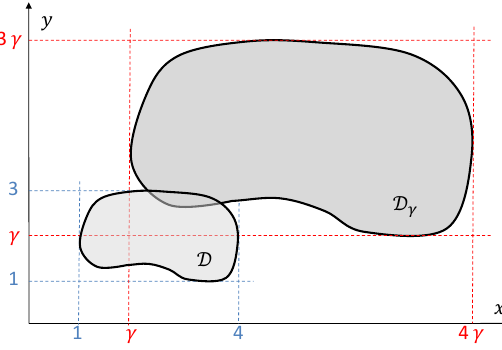
Figure 4. Constructing region D γ from region D